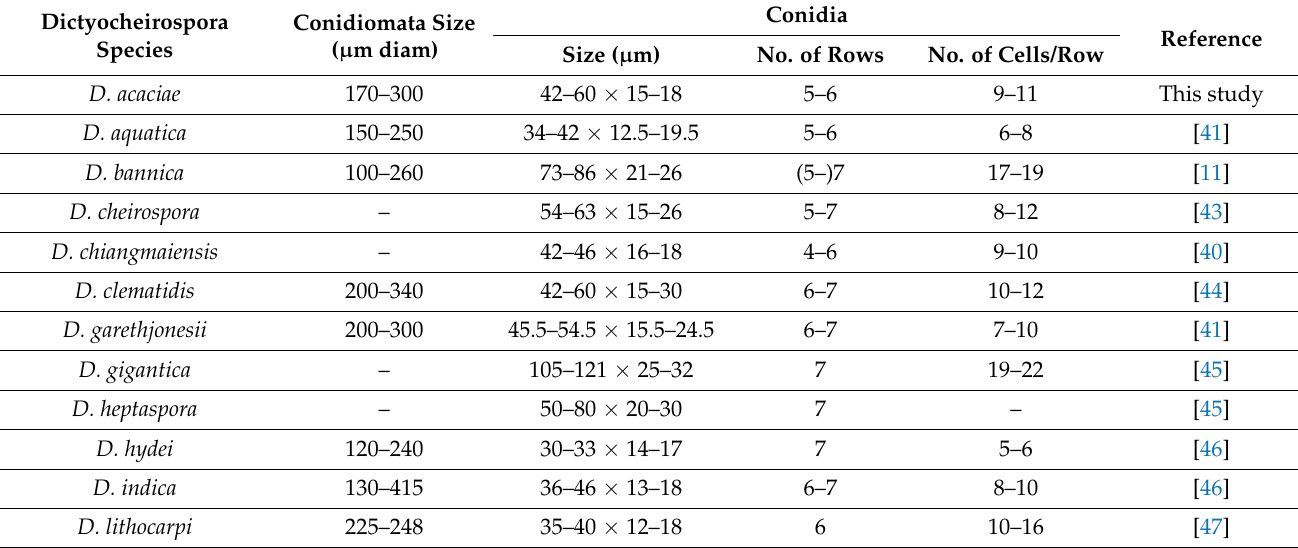
Table 2. A synopsis of all the known species of Dictyocheirospora